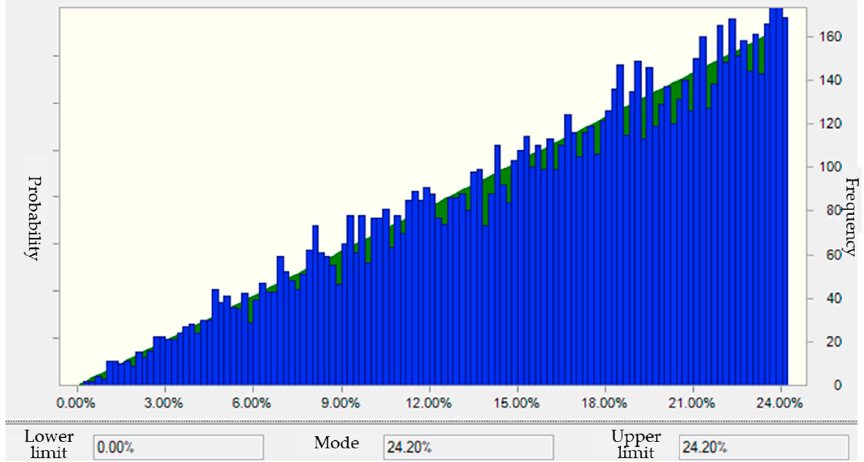
Figure 9. Corporate tax probability distribution (triangular distribution).